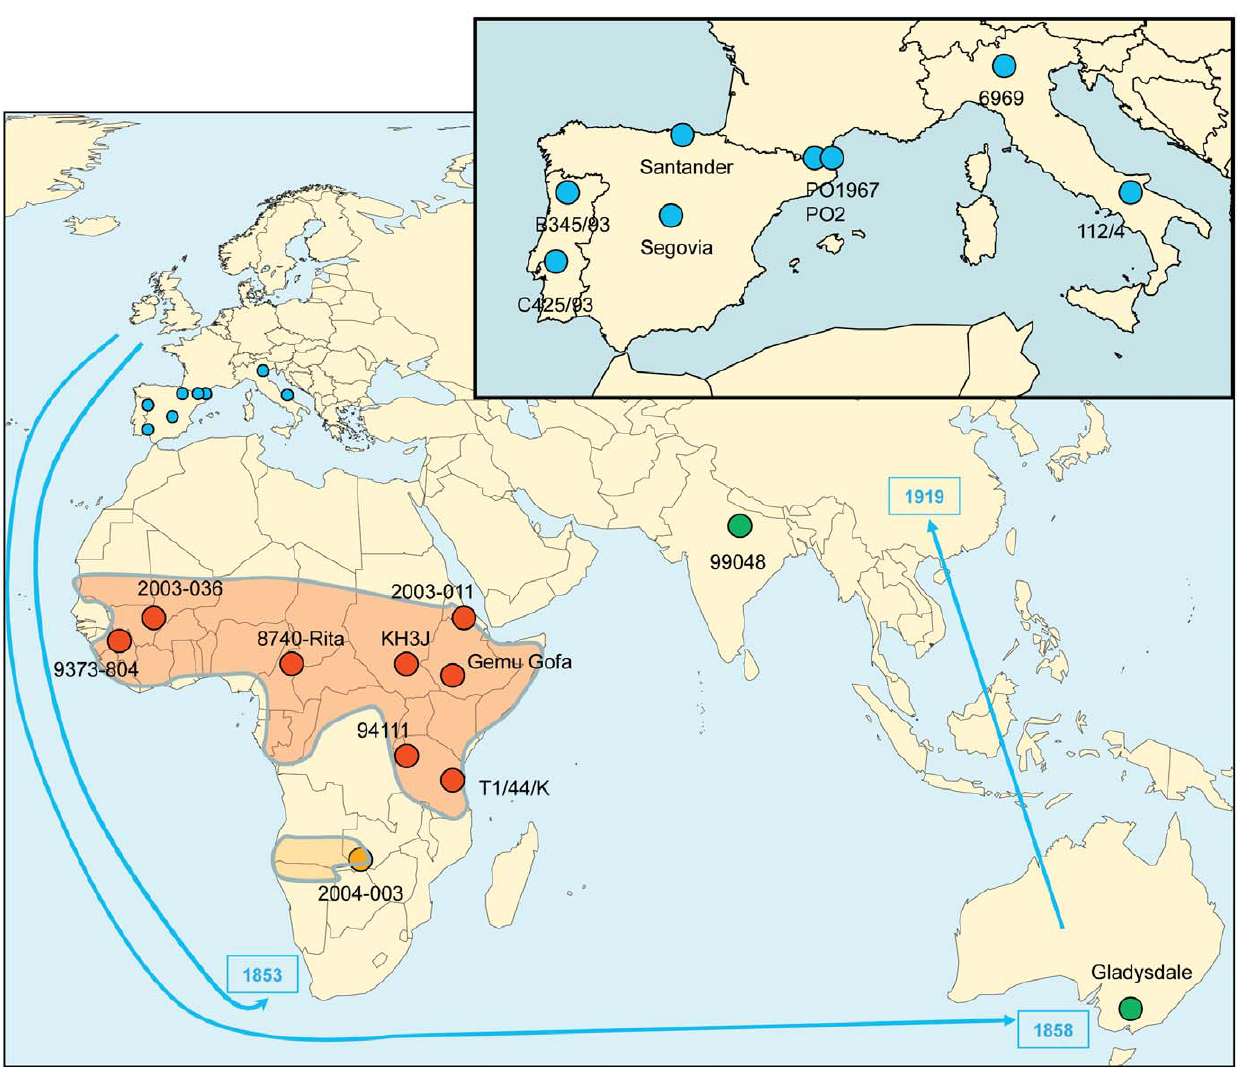
Figure 1. Geographical distribution and diversity of the M.mycoides subsp. mycoides ‘‘Small Colony’’ (MmmSC) strains studied. Twenty MmmSC strains were included in this study. Two strains were chosen from each European country that was infected in the 20th century (blue dots). Eight strains from Sub-Saharan Africa were selected to reflect the widest geographical diversity in this region (red dots). One strain was chosen to represent the southern part of the African continent (orange dot). In addition, one strain from Australia and one from India were also included (green dots). The reference strain, PG1 T , is not represented as its origin is not known. The arrows indicate the routes of contagious bovine pleuropneumonia (CBPP) expansion during the 19th century as inferred from historical documents. The dates of introduction are indicated at the tip of the arrows. The red and orange shaded areas in Africa represent the most probable zones where CBPP is now enzootic.